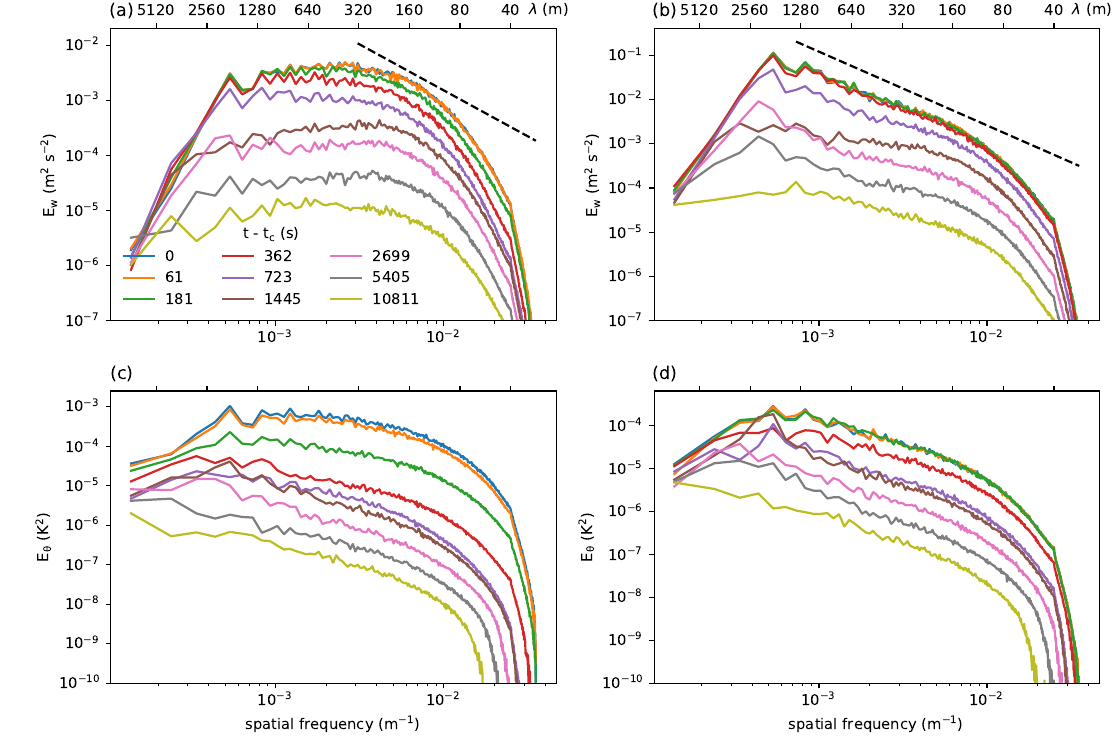
Figure 8. Two-dimensional spectra of vertical velocity at z = ( a ) 40 and ( b ) 460 m and those of potential temperature at z = ( c ) 50 and ( d ) 470 m in the free CBL. Dashed lines of − 5/3 slope are